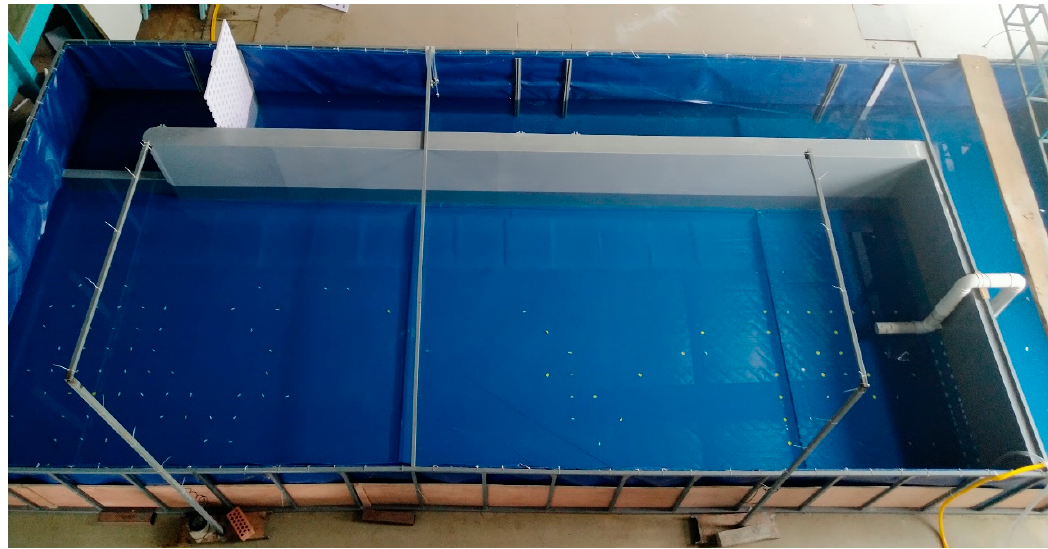
Figure 2. Experimental model